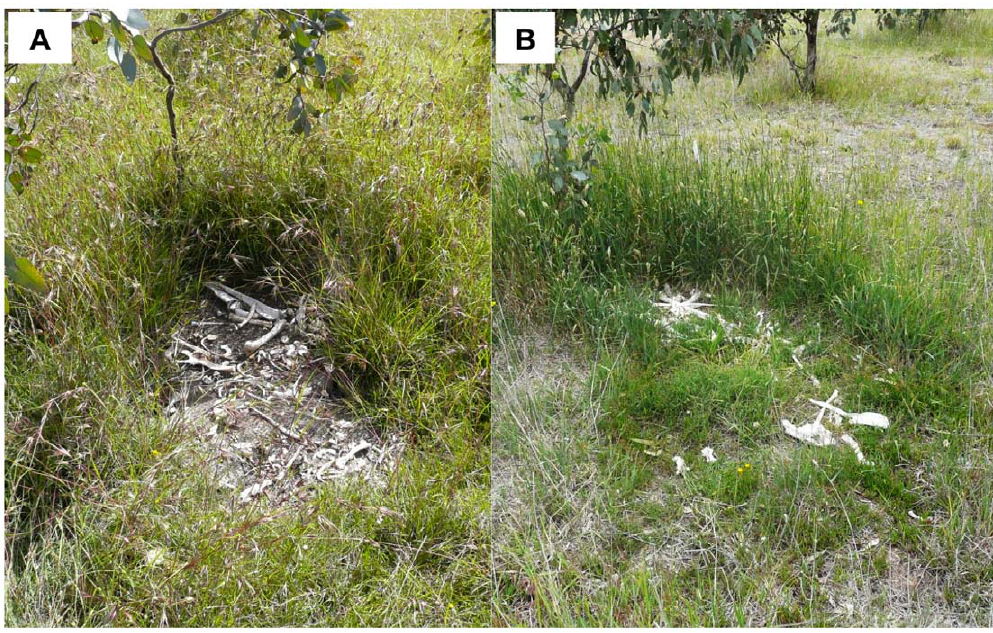
Figure 3. Recolonisation of plants 52 weeks after carrion addition. Very little recolonisation had occurred in the native-dominated grassland sites (a), whereas re-colonisation had progressed further in all exotic-dominated grassland sites (b), reflecting greater tolerance of some exotic species to extremely high nutrients. These examples indicate a different succession trajectory for native versus exotic grassland plant assemblages, with recolonisation occurring over different time scales.